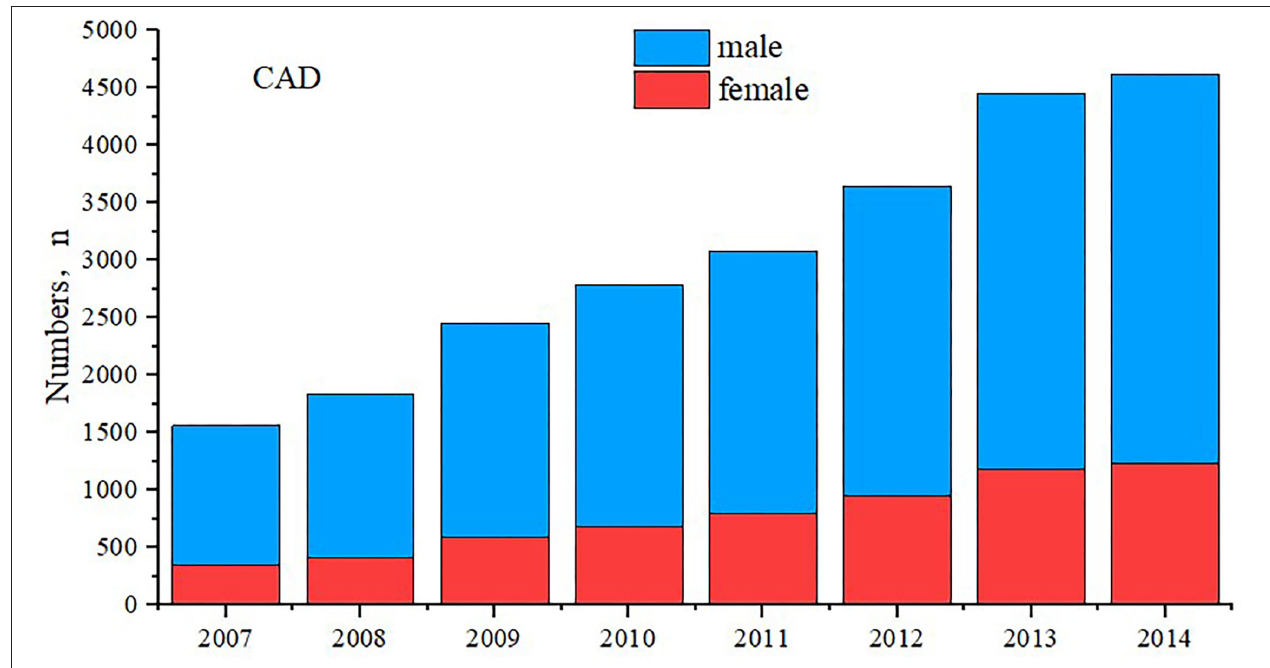
FIGURE 1 | Patients admitted between January 2007 and December